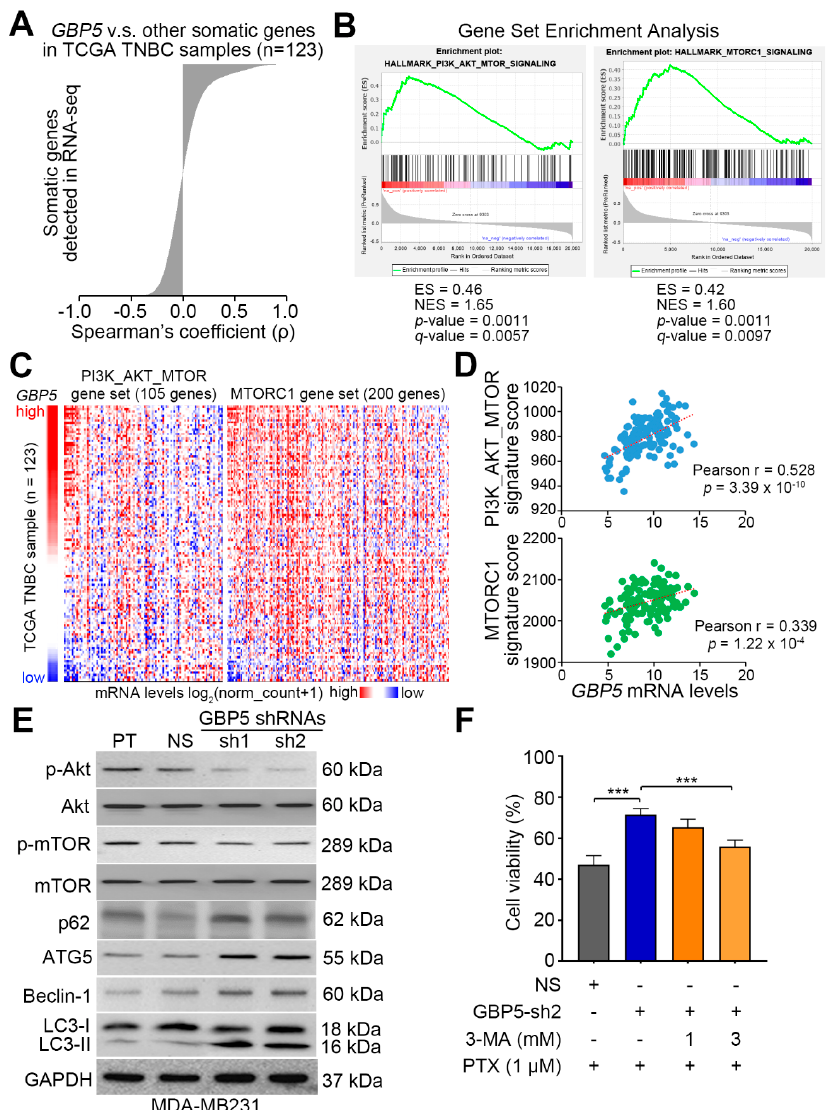
Figure 5. GBP5 activates Akt/mTOR signaling axis and inhibits autophagy activity to the paclitaxel- sensitive TNBC cells. ( A ) A histogram for the Spearman’s coefficient ( p ) values derived from the Spearman correlation test against the co-expression of GBP5 with other somatic genes detected by RNA-sequencing method in 123 TNBC samples deposited in TCGA database. ( B ) The enrichment score (ES) derived from the correlation of GBP5 signature with the PI3K_AKT_MTOR (left) and MTORC1 (right) gene sets was plotted as the green curve. The parameters of enrichment score (NES), nominal p value and false discovery rate q value are shown as insets. ( C ) Heatmap for the transcriptional profiling of GBP5 and PI3K_AKT_MTOR (left)/MTORC1 (right) gene sets detected by RNA-sequencing tool in TNBC sample from TCGA database. ( D ) Scatchard plot for the expression of GBP5 and PI3K_AKT_MTOR (upper)/MTORC1 (lower) gene sets in the TNBC samples from TCGA database. ( E ) Western blot analyses for the protein levels of phosphorylated Akt ( p -Akt), Akt, p -mTOR, mTOR, p62, ATG5, Beclin-1, LC3-I/II and GAPDH in the indicated cell variants of MDA-MB231 cells. ( F ) A histogram for the cell viability (percentages relative to untreated groups) in the non-silencing control MDA-MB231 cells and GBP5-silencing MDA-MB231 cells pretreated without or with autophagy inhibitor 3-Methyladenine (3-MA) at 1 and 3 mM prior to the treatment with paclitaxel (PTX) at 1 µ M for 72 h. Non-parametric Mann–Whitney U test was used to estimate statistical significance. The symbol “***” denotes p <